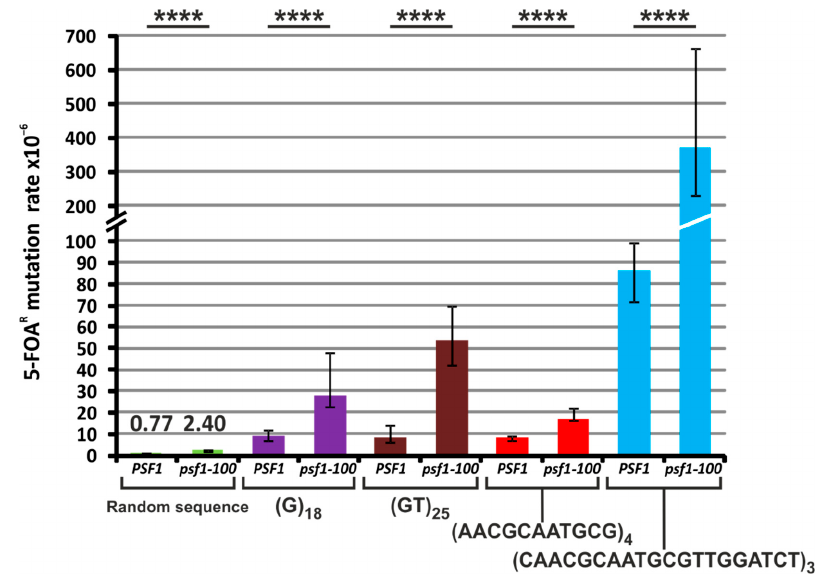
Figure 5. Spectrum of CAN1 forward mutations for the psf1-100 pol2-4 rev3 Δ strain. Rates for particular types of base substitutions, insertions, deletions and complex mutations are shown. Data for isogenic rev3 Δ , psf1-100 rev3 Δ , and pol2-4 rev3 Δ strains were already shown previously [49]. Rates, percentages, and relative rates are shown in Table S7. Statistical analysis results are shown in Table S8. Int. J. Mol. Sci. 2020 , 21 , x FOR PEER REVIEW